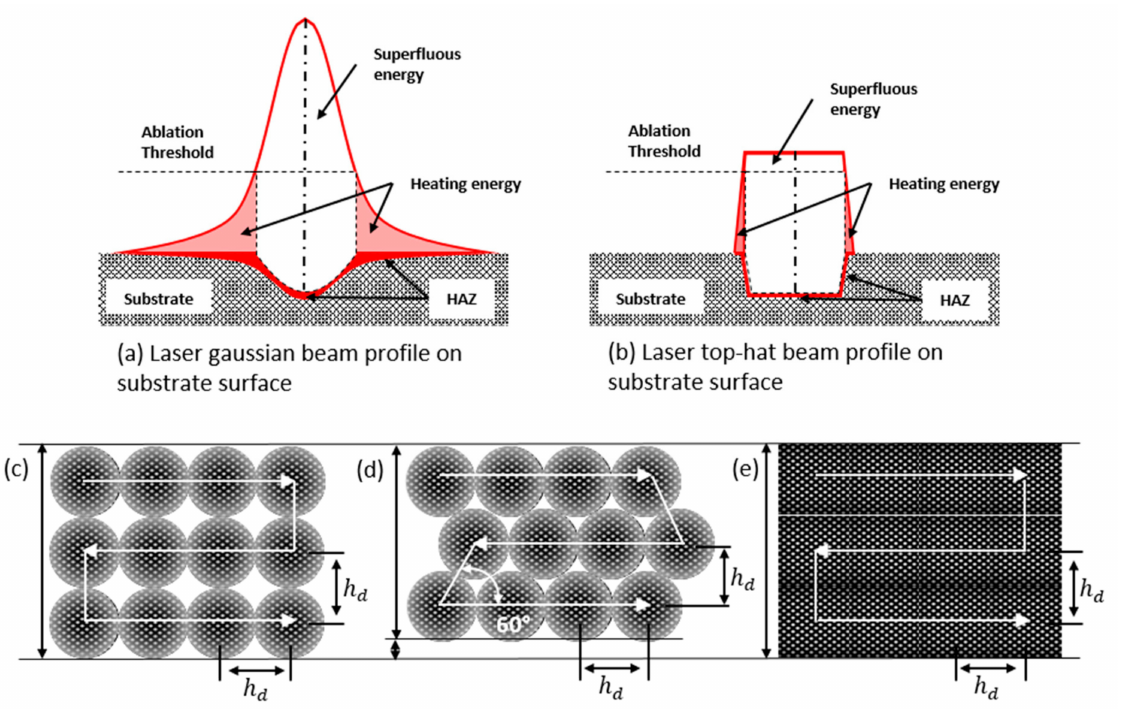
Figure 1. Laser energy contribution to material ablation and formation of Heat affected Zone (HAZ) when ( a ) Gaussian and ( b ) top-hat beams are utilized Illustration of structured area coverage during DLIP with ( c ) square and ( d ) hexagonally distributed Gaussian laser spots as well as ( e ) top-hat shaped laser beam. h d denotes a hatch distance between two consecutive